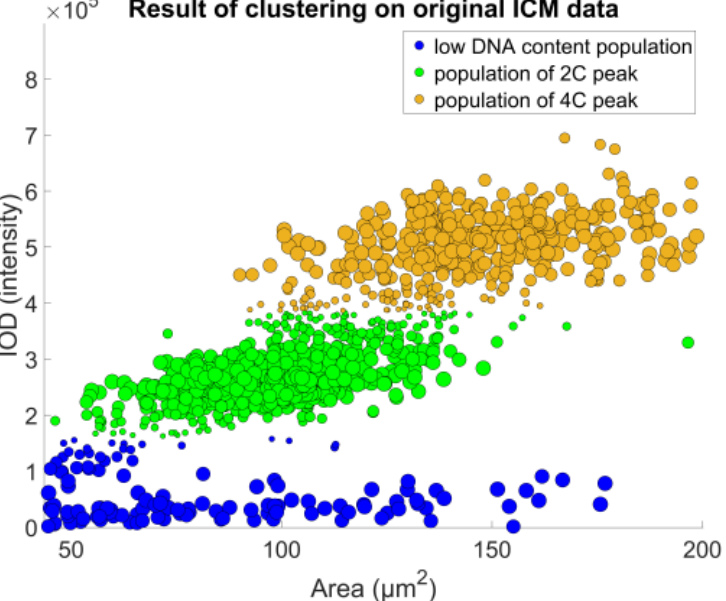
Figure 10. The original ICM data scatterplot recolored based on the clustering results: Data point radii represent the cluster membership value. Classification results identified the peak populations, and provided the basis of the measurement of their DNA content values.